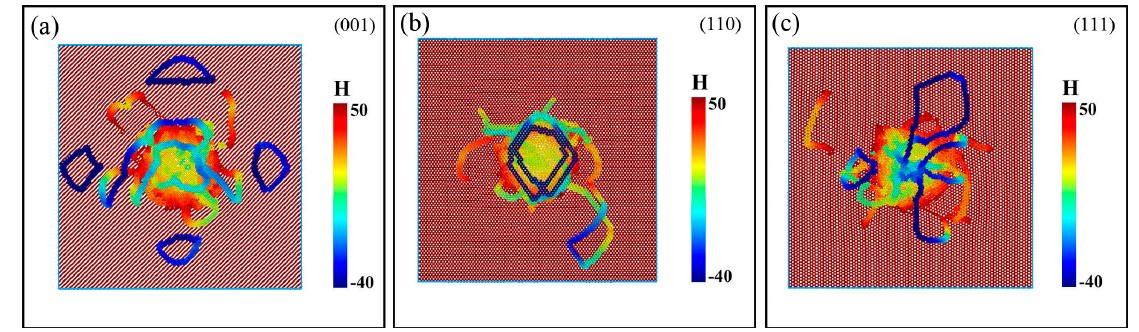
Figure 7. Upward view of films under indentation on different surfaces. ( a ), ( b ) and ( c ) represent the (001), (110) and (111) surfaces, respectively. H-value represents position of particles along Z direction.